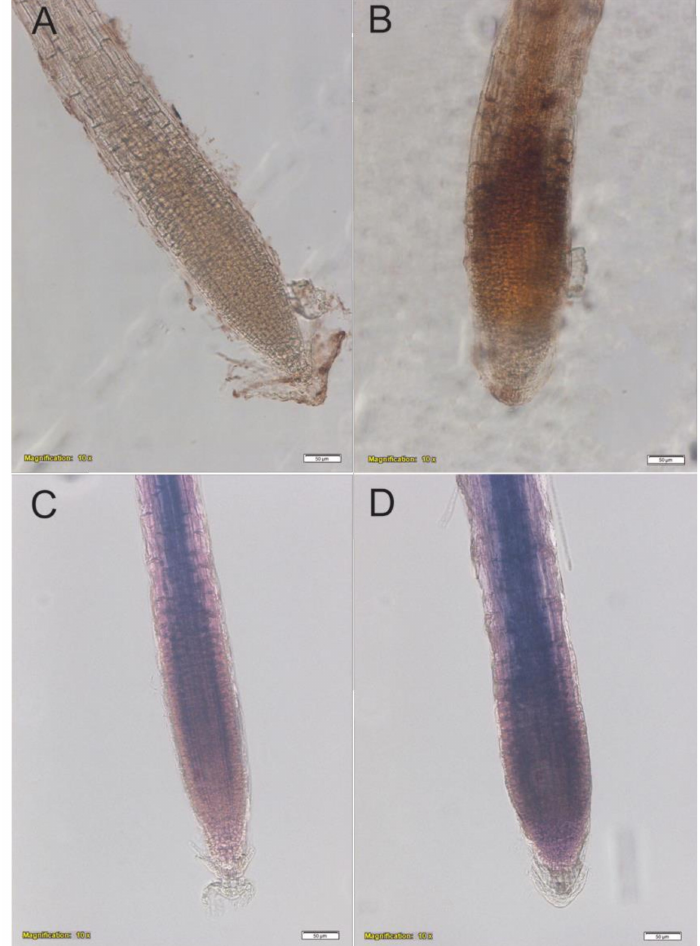
Figure 8. In situ hydrogen peroxide (dark brownish color) ( A , B ) and superoxide (dark blue color) ( C , D ) localization in roots of A. thaliana untreated ( A , C ) and treated with 50 µ M protodioscin for 6 d ( B , D ). Image magnification 10 × , scale bar 50 µ m. N =